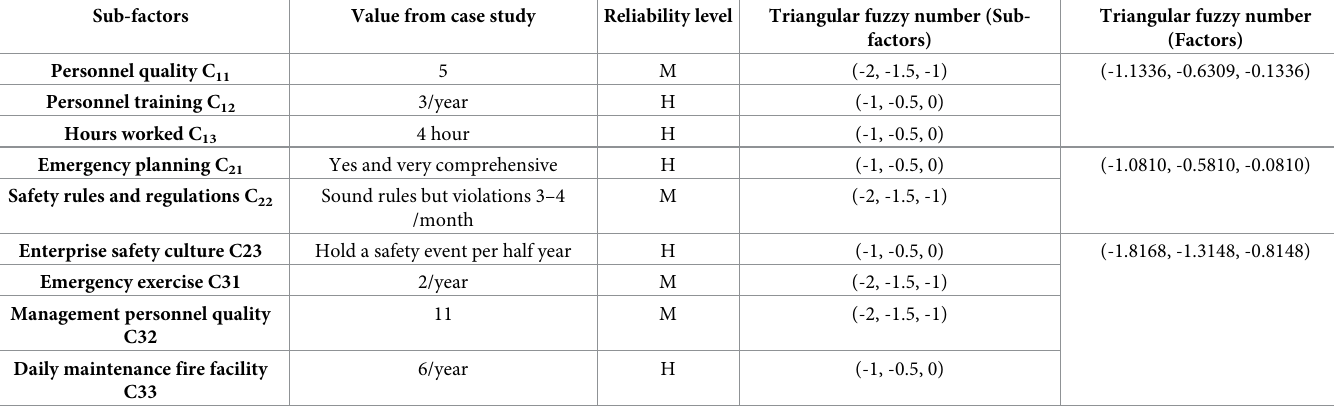
Table 20. Assessment of the emergency response using